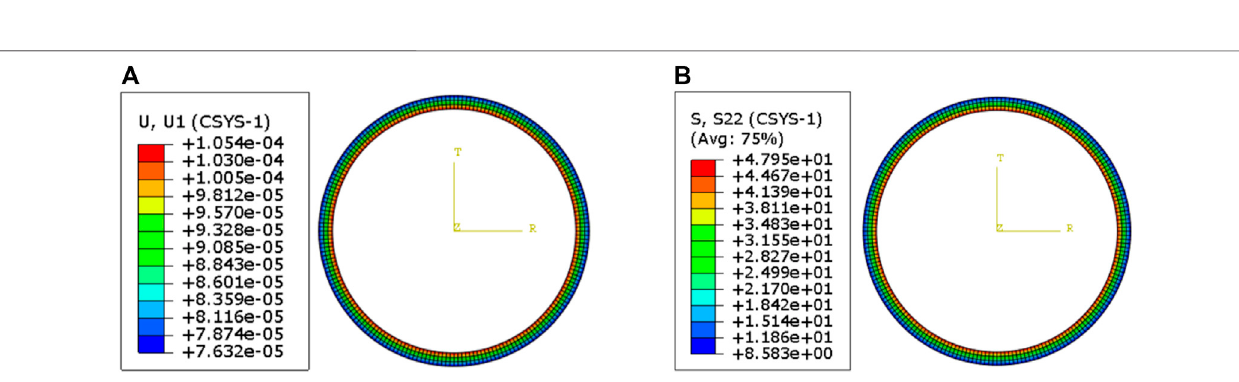
FIGURE 8 | Radial deformation and circumferential stress of concrete lining. (A) Radial deformation of concrete lining. (B) Circumferential stress of concrete lining.